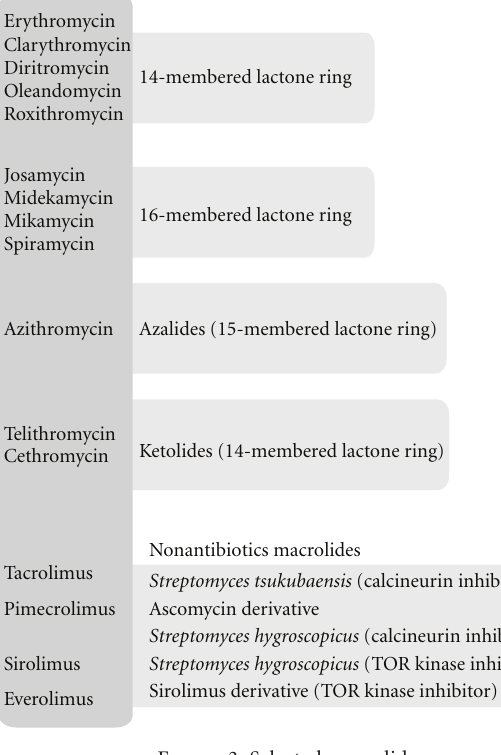
Figure 3: Selected macrolides.